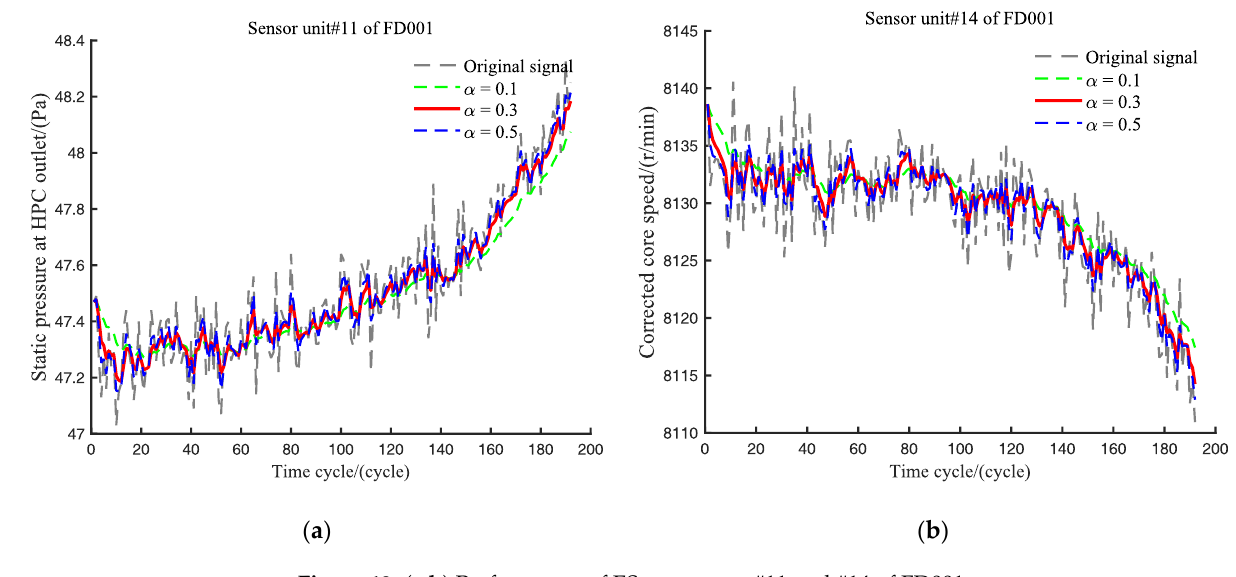
Figure 13. ( a , b ) Performance of ES on sensors #11 and #14 of FD001. Table 10. Different feature subsets.